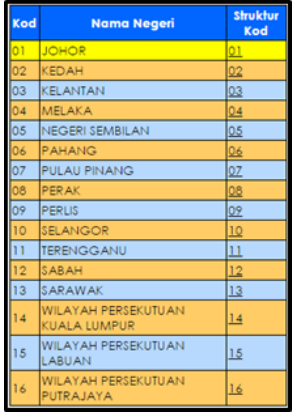
Figure 2. UPI code for each state in Malaysia